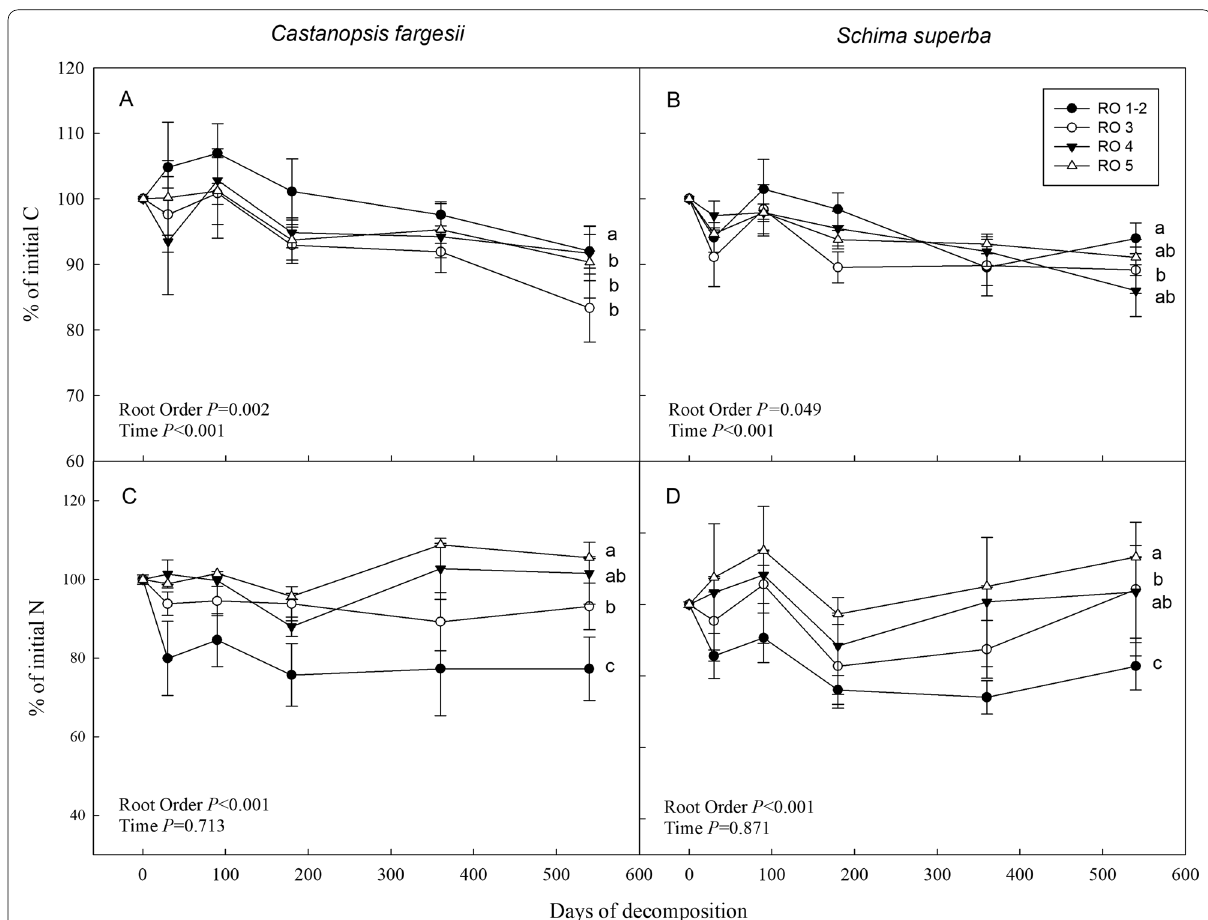
Fig. 3 C and N dynamics (% of initial C and N) during the 540-day decomposition for roots of different branch orders of the two species. RO1–2 refers to the 1st- and 2nd-order roots, RO3, RO4 and RO5 refer to the 3rd-, 4th- and 5th-order roots, respectively. Error bars represent ANCOVA was conducted to compare the differences between roots of different branch orders with decomposition time as the covariate. Different letters at the end of the curves indicate significant differences between two root-order classes ( P